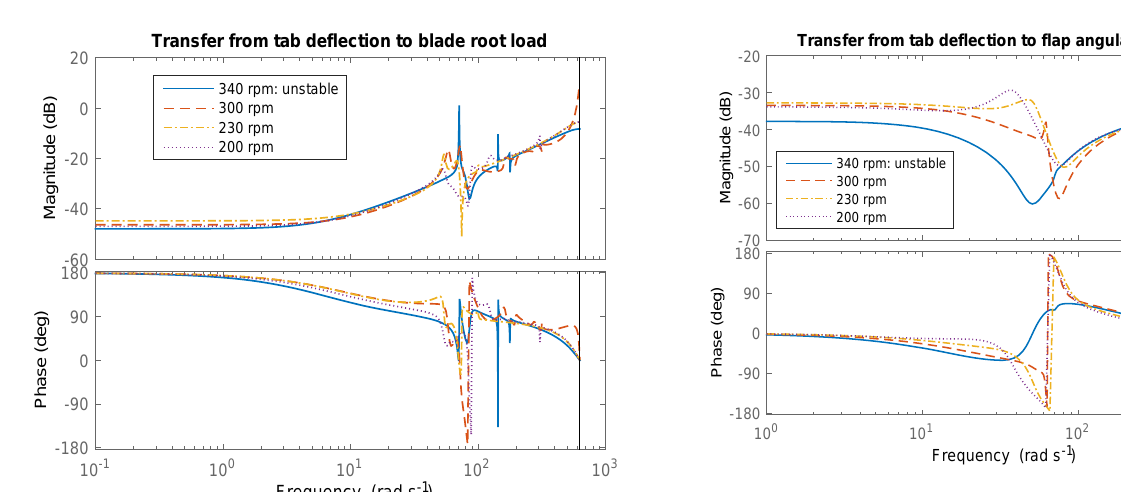
Figure 14. Transfer from piezobender actuators to free floating flap angle at different wind